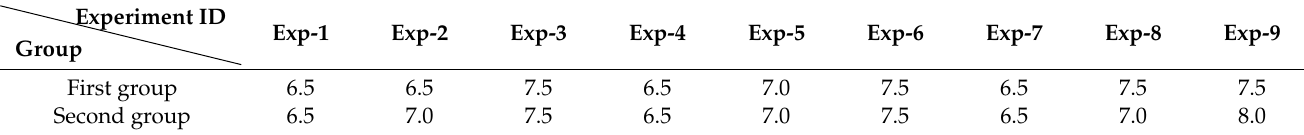
Table 1. Critical pH values for gelation.